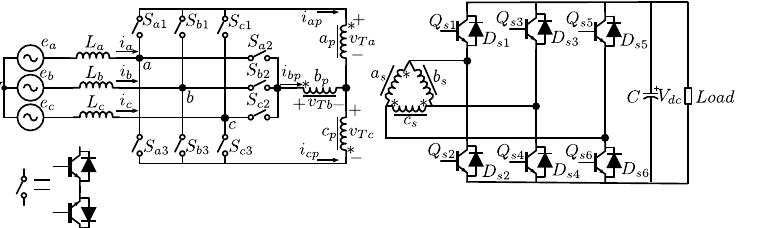
Figure 14. Single-stage isolated three or two-phase AC/DC converter with Y- ∆ connected symmet- rical transformers. When there is a fault or at light load conditions the converter operates in dual transformer mode. For instance, during S c 1 fault the switches S a 1 , S b 1 , and S c 3 are switched on, and the current flows into the dotted terminal of a p and out of the dotted terminal of c p . Hence, the diodes D s 1 , D s 3 , and D s 6 are on, providing uninterrupted output power.